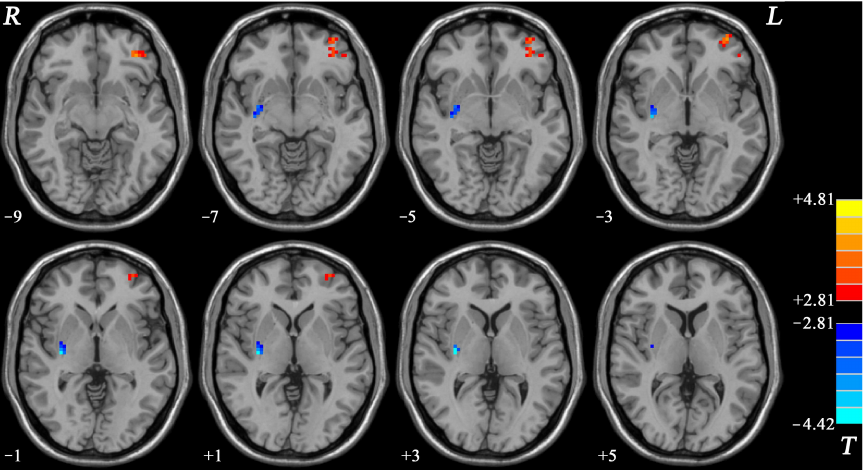
Figure 2. Brain regions with changed NH of fronto-limbic network at rest in OCD. The color bar indicates the T values from two-sample t -tests. NH = network homogeneity, OCD = obsessive– compulsive disorder, L = left, R = right.